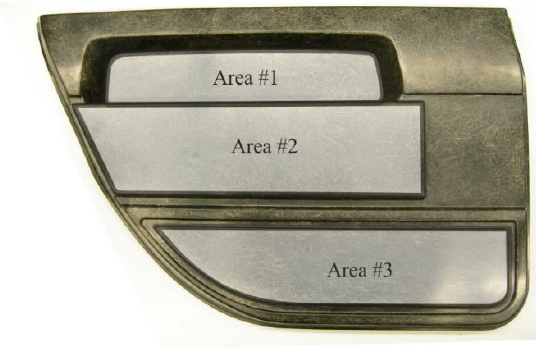
Figure 4. Integration areas in the car door panel.